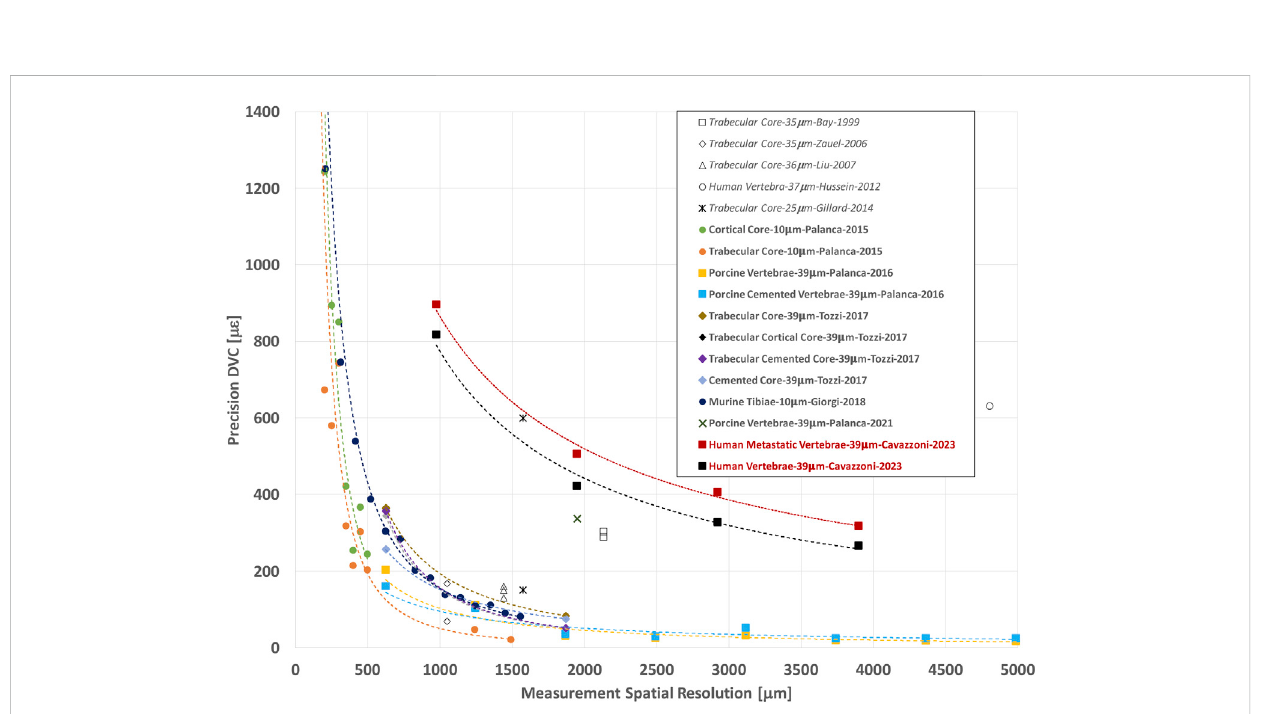
FIGURE 8 Relationship between the precision (SDER; median values in case more specimens were analysed per group) and the spatial resolution of the DVC strain measurement (in μ m). The spatial resolution of the DVC is equivalent to the NS used in this study. In other studies, it is referred to Sub-Volume size or similar. For each study the specimen type, microCT image resolution, fi rst author of the manuscript, and year of publication of the manuscript are reported. Study performed with BoneDVC approach are reported in bold and study performed with other approaches are reported in